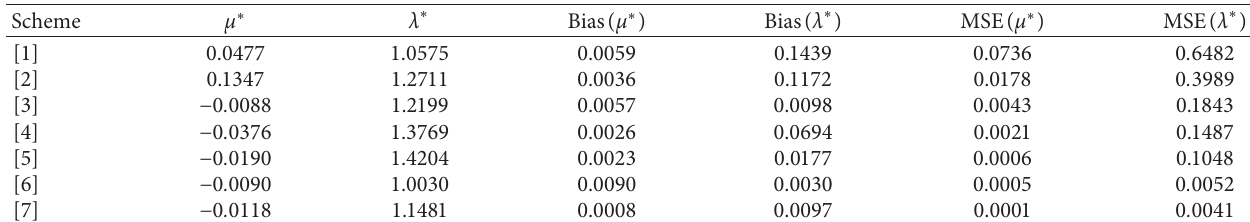
Table 3: ABLUEs μ ∗ , λ ∗ , biases, and MSEs for μ and λ from APE distribution when α � 1 . 5.